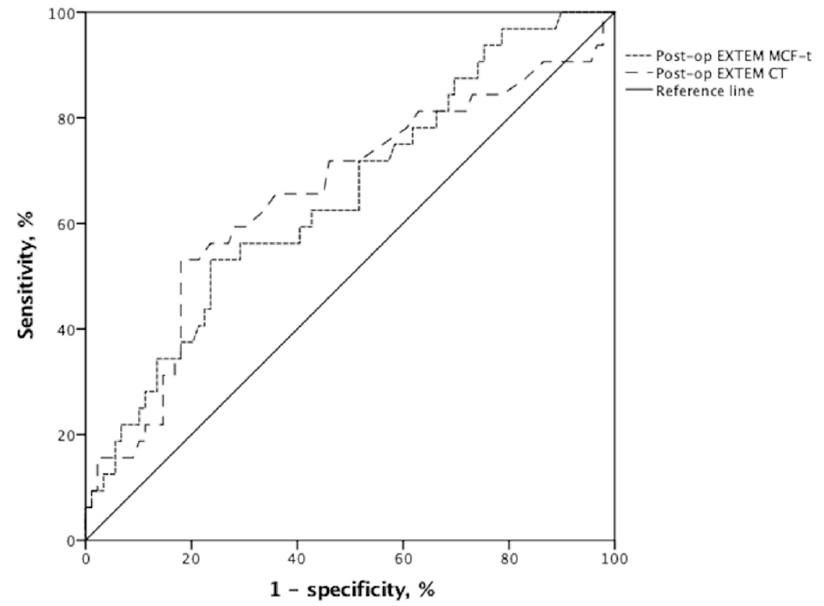
Figure 2. Receiver operating characteristic diagram for independent risk factors predicting EAD after LDLT: postoperative EXTEM CT (AUC (95% CI) = 0.654 (0.536–0.772); p = 0.010) and EXTEM MCF-t (AUC (95% CI) = 0.690 (0.584–0.797); p = 0.001). Table 3. Results of thromboelastometric assays according to development of EAD or lack thereof. EAD, N = 32 Non-EAD, N = 89 p -Value Pre-op Parameters EXTEM CT, sec